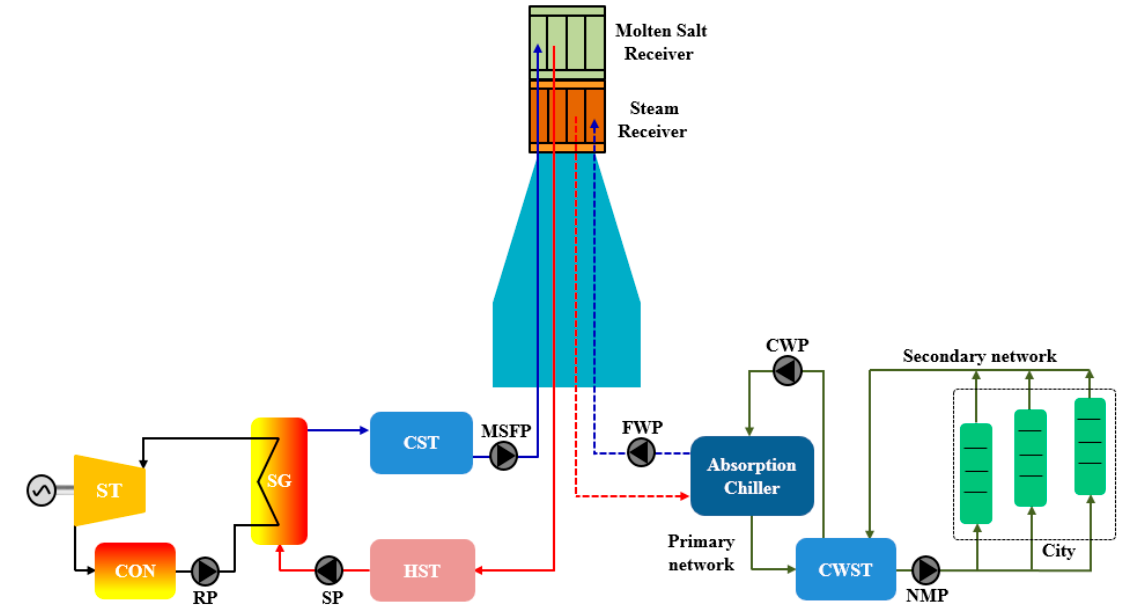
Figure 5. Solar power tower and DC system proposed by Marugán-Cruz et al., adapted from [30]. Note: